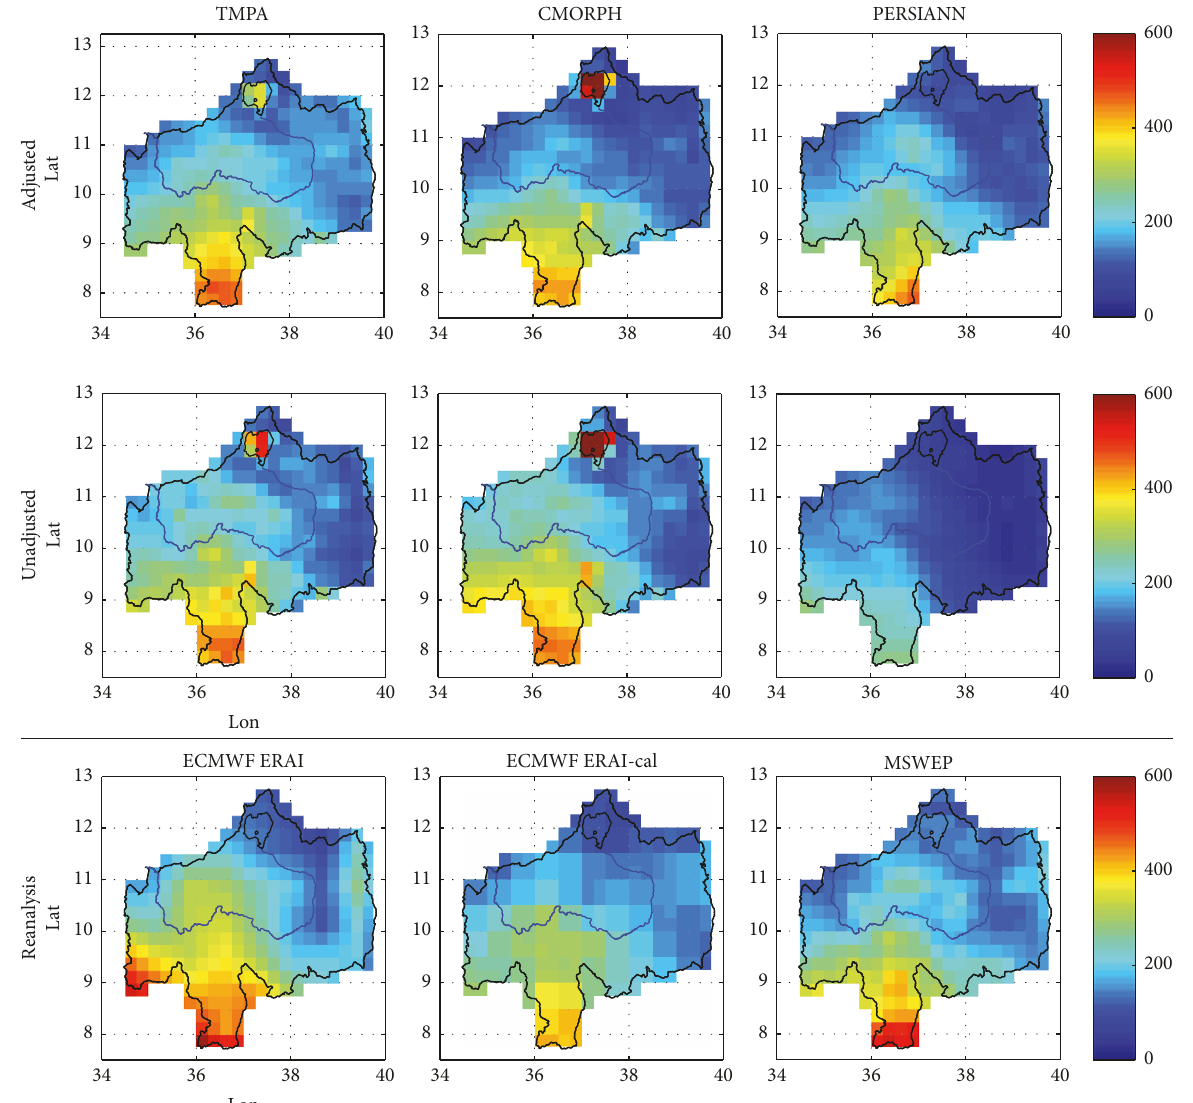
Figure 3: Spatial pattern of mean seasonal rainfall (mm) for the period March to